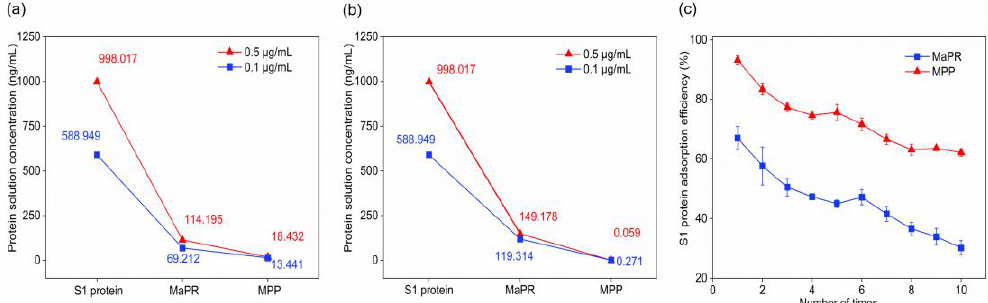
Figure 4. The adsorption efficiency of S1 protein was quantified by ELISA. ( a ) Concentration of SARS-CoV-2 S1 protein in solution after MPP adsorption for 30 s; ( b ) Concentration of SARS-CoV-2 S1 protein in solution after MPP adsorption for 1 min; ( c ) The efficiency of MPP resin at repeatedly adsorbing SARS-CoV-2 S1 protein.